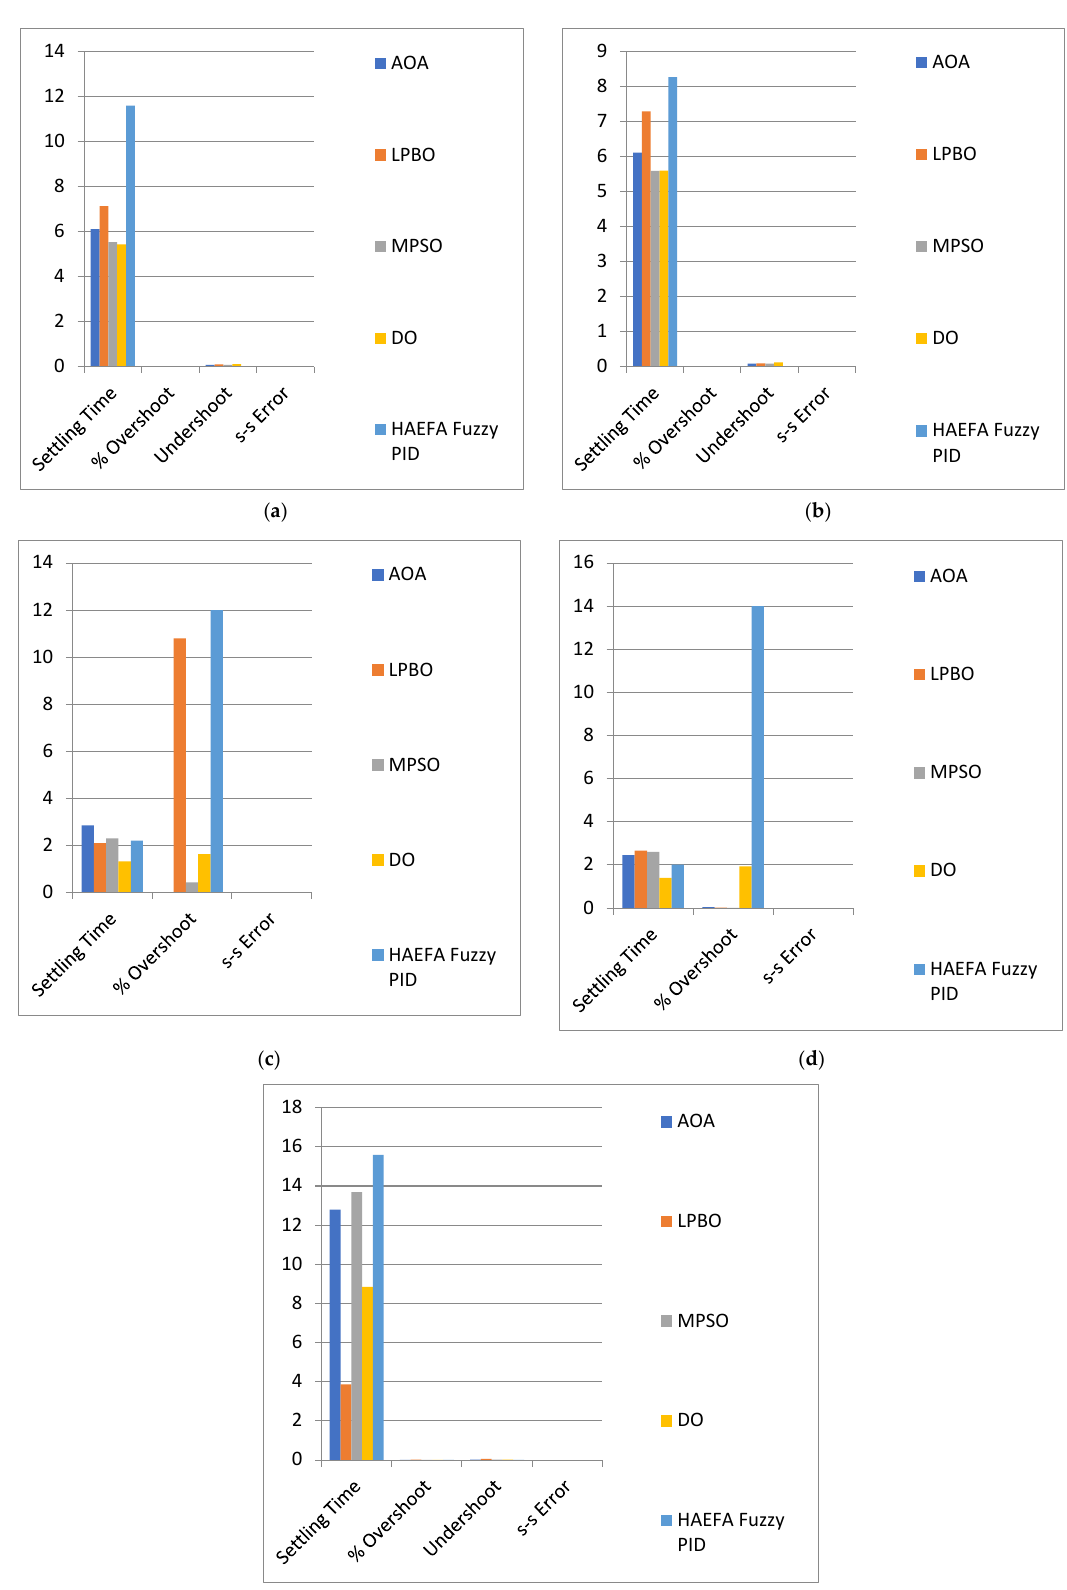
Figure 9. Graphical comparison in a two-area multi-source IPS.( a ) ∆ f 1 ;( b ) ∆ f 2 ;( c ) V t1 ;( d ) V t2 ;( e ) P tie-line.